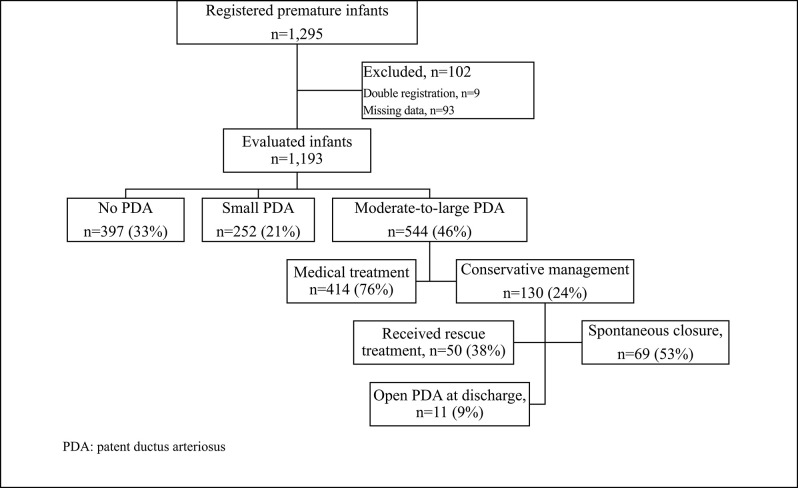
The flow chart of the study.